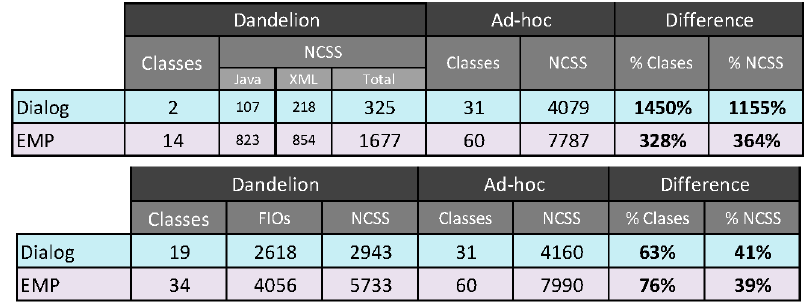
Figure 9. Comparison, in number of public classes and NCSS between developing two different UIs using Dandelion or using the different technologies directly. On the first table we are assuming that all the required FIOs are already available, on the second one we are also counting the effort required to implement all the FIOs required. The “Difference” column shows the % of increment in public classes and NCSS between using Dandelion or not.